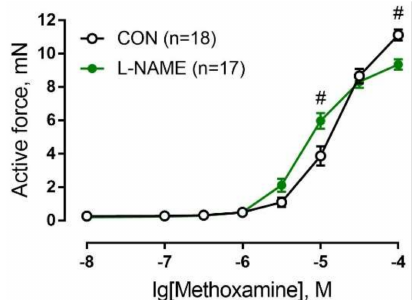
Figure 4. Concentration-dependent contractile response of saphenous arteries of two-week-old offspring from the control (CON) and L-NAME groups to the α 1 -adrenoceptor agonist methoxamine. Data are presented as the mean ± S.E.M., n , number of animals. # p < 0.05 compared to respective value in the control group (two-way ANOVA followed by Šid á k’s post hoc